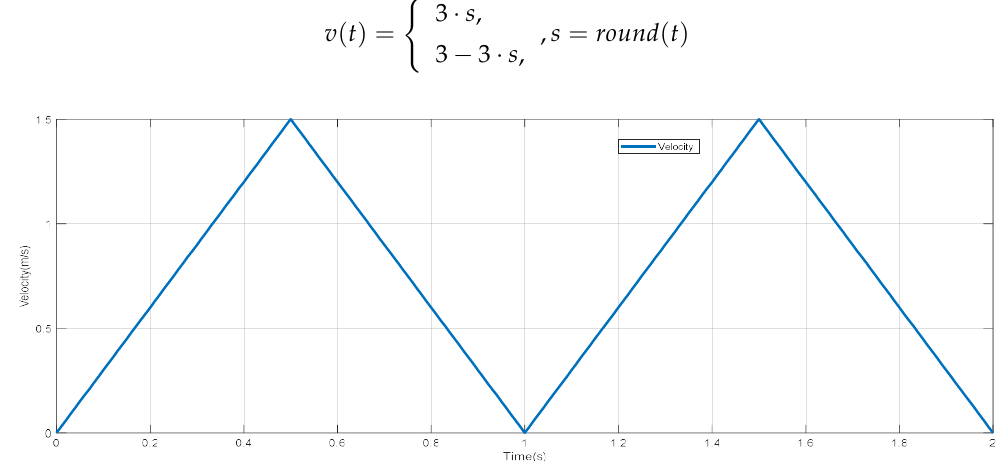
Figure 6. The velocity of the trigonal case.